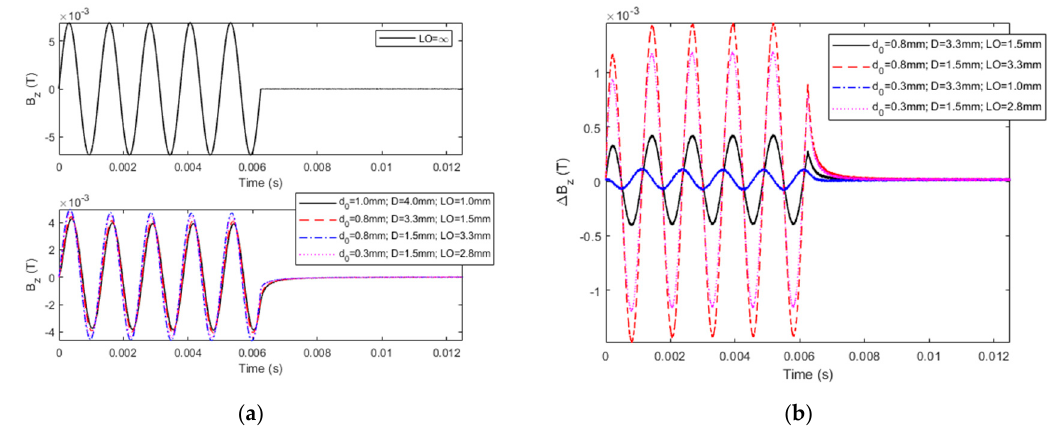
Figure 8. Experimental PMEC signals: ( a ) acquired signals of B z ; ( b ) difference signals.